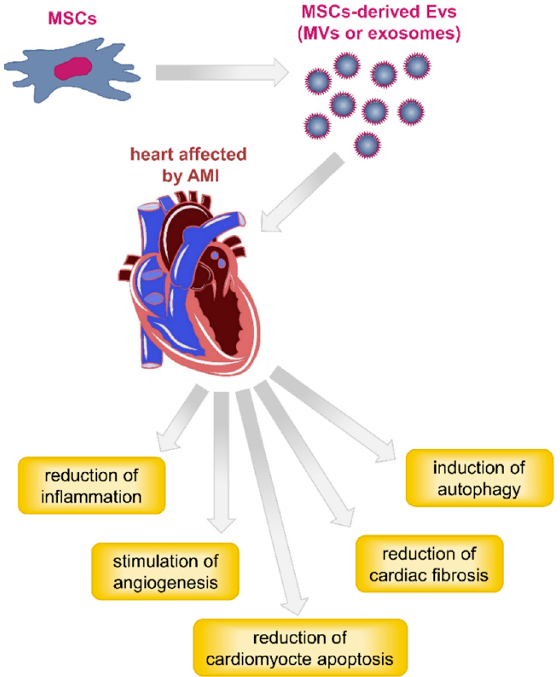
Figure 4. Schematic diagram showing the beneficial therapeutic effects of MSC ‐ derived EVs (MVs or exosomes) in heart affected by acute myocardial infarction (AMI). These are reduction of the